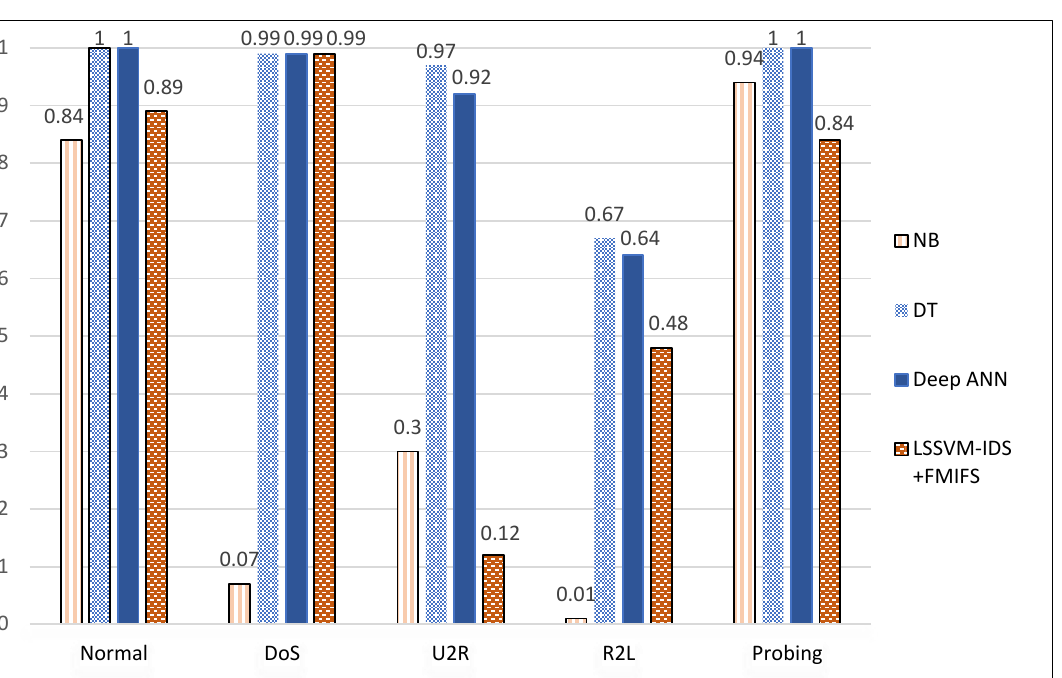
Table 13. Choice of Anomaly Detectors for SDWSNs (binary classification).